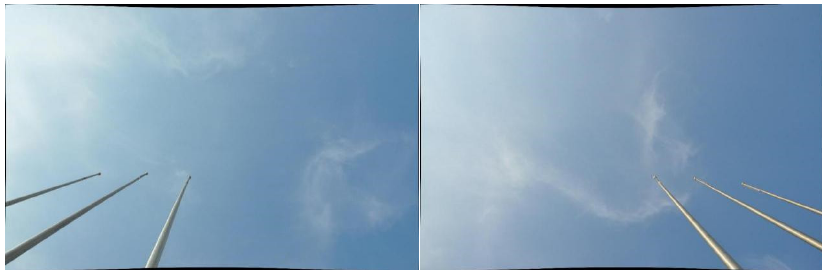
Figure 10. Pictures taken by the ( left ) and ( right ) cameras. The pixel coordinates of the center point of the picture were (2144,1424); in the pictures taken by the left and right cameras, the pixels at the top of the middle flagpole were (2913,1849) and (1465,1797), respectively. Camera distance (baseline) was 7.35 m, the measured shadow length was 31.2 m, and the measured shadow orientation was 94 ◦ (0 ◦ due north). The angle between the connecting line of flagpole and the left camera and the connecting line of the two cameras was 28 ◦ , and the distance from the flagpole to the left camera was 3.9 m. The angle between the connecting line of the flagpole and the right camera and the connecting line of the two cameras was 30 ◦ , and the distance from the flagpole to the right camera was 3.8 m. According to the principle of calculating the relative position between the flagpole and the cameras, the angle between the connecting line of the flagpole and the left camera and the connecting line of the two cameras was 28.93 ◦ , with an error rate of 3.32%. The distance from the left camera to the flagpole was 3.66 m, with an error rate of 6.15%.